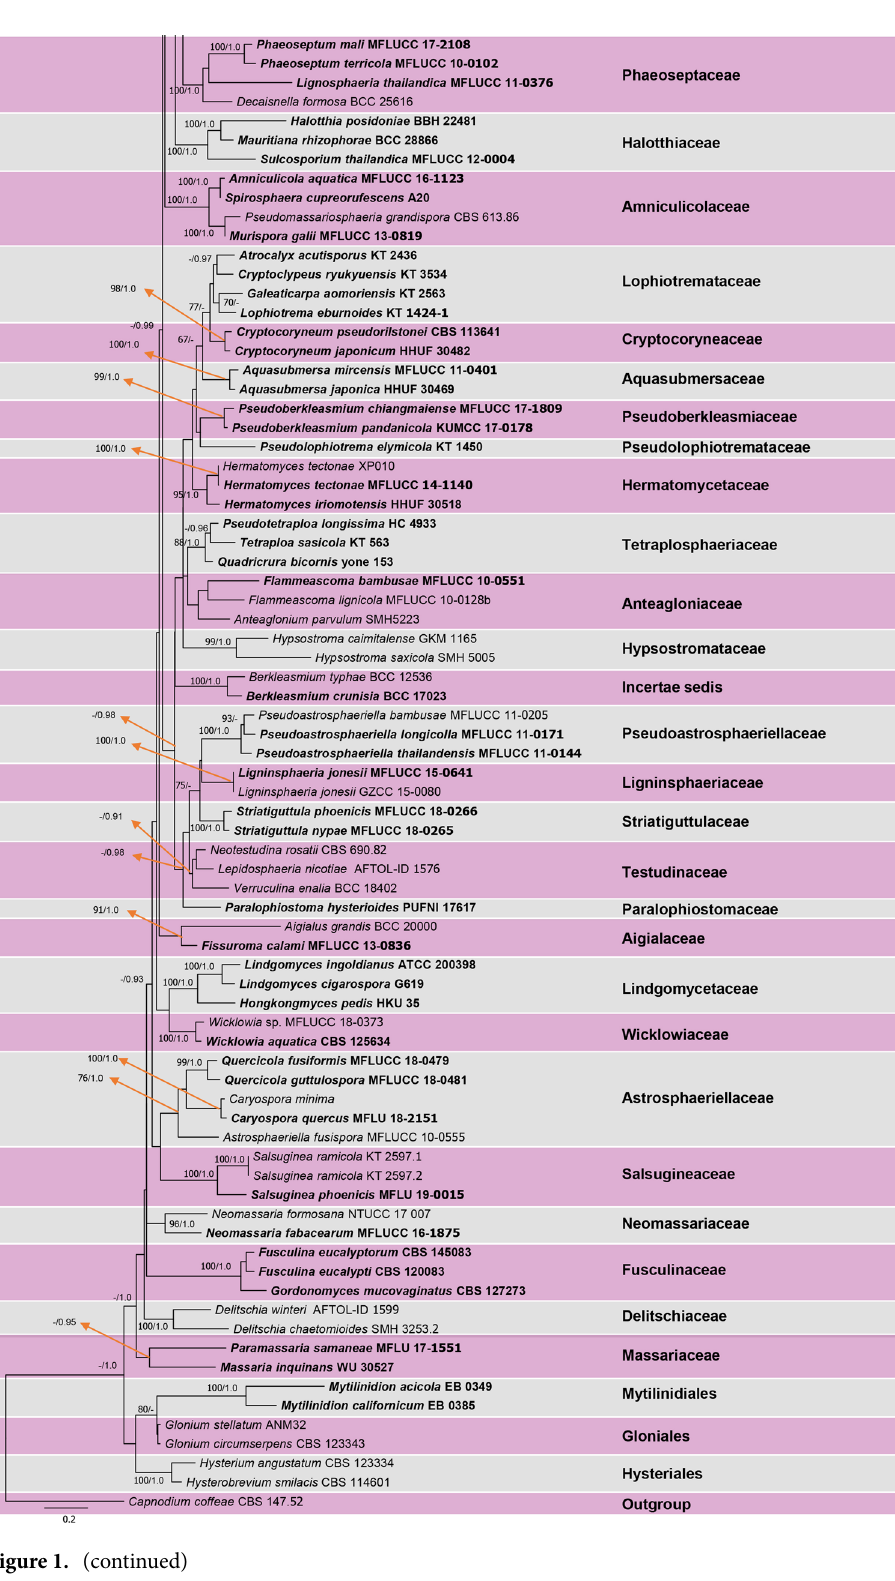
Lophiostomataceae and forms a distinct clade which cannot be assigned to any known family in Pleosporales. Therefore, the new family, Sublophiostomataceae is established to accommodate this genus.